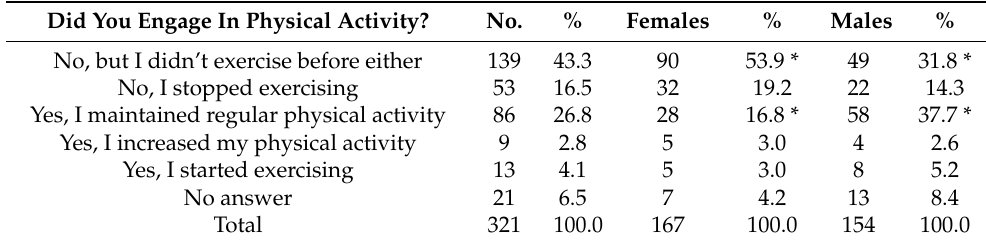
Table 8. Physical exercise during the